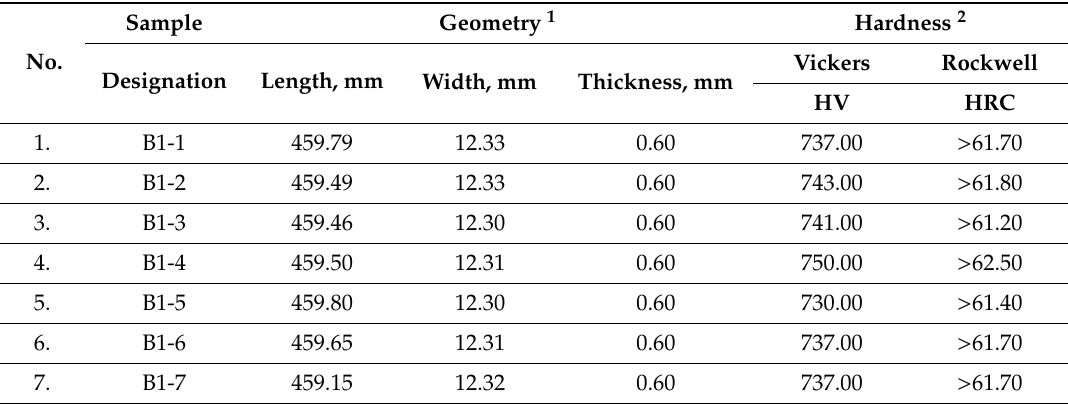
Table 1. Characteristics of the industrial cutting blades used in the tests.